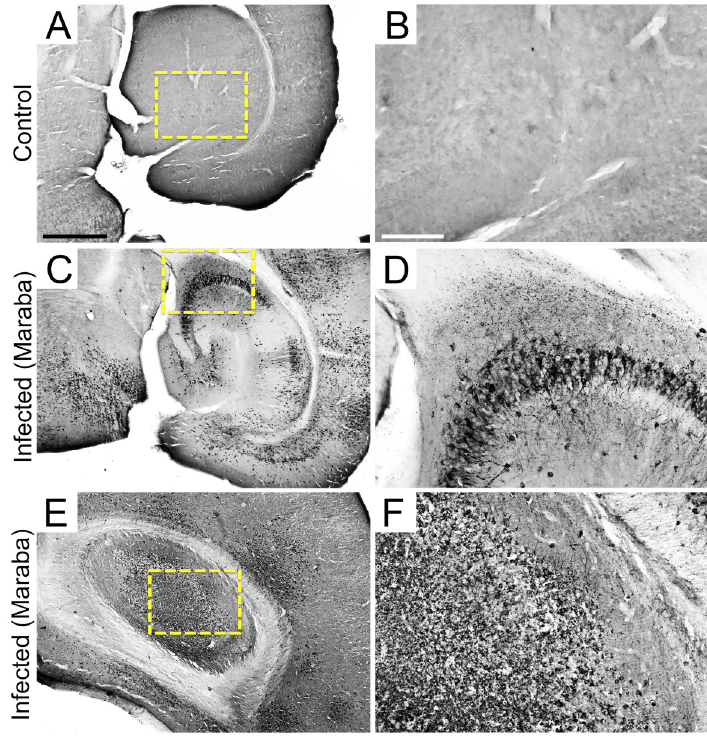
Figure 3. Photomicrographs after Maraba virus antigen immunolabelling of Control ( A , B ) and 6 days post-infection infected mouse sections ( C to F ). Yellow-dotted square areas indicate the regions of high-power images. Scale bars A , C , E : 650 m m; B , D , F : 150 m m.